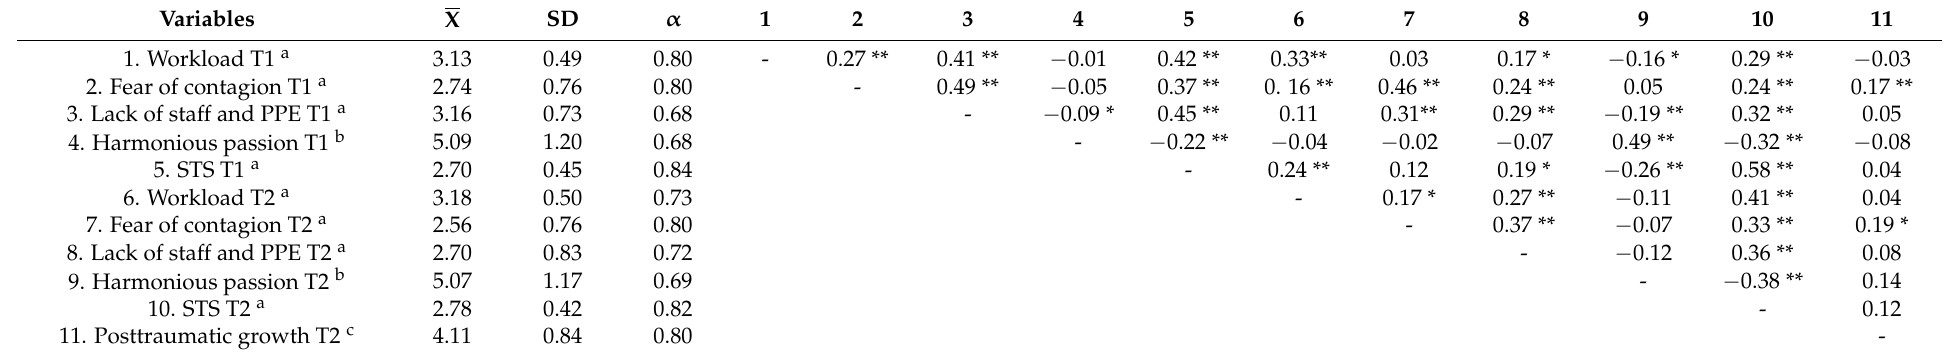
Table 2. Means, standard deviations, internal consistency indexes (Cronbach’s alpha) and bivariate